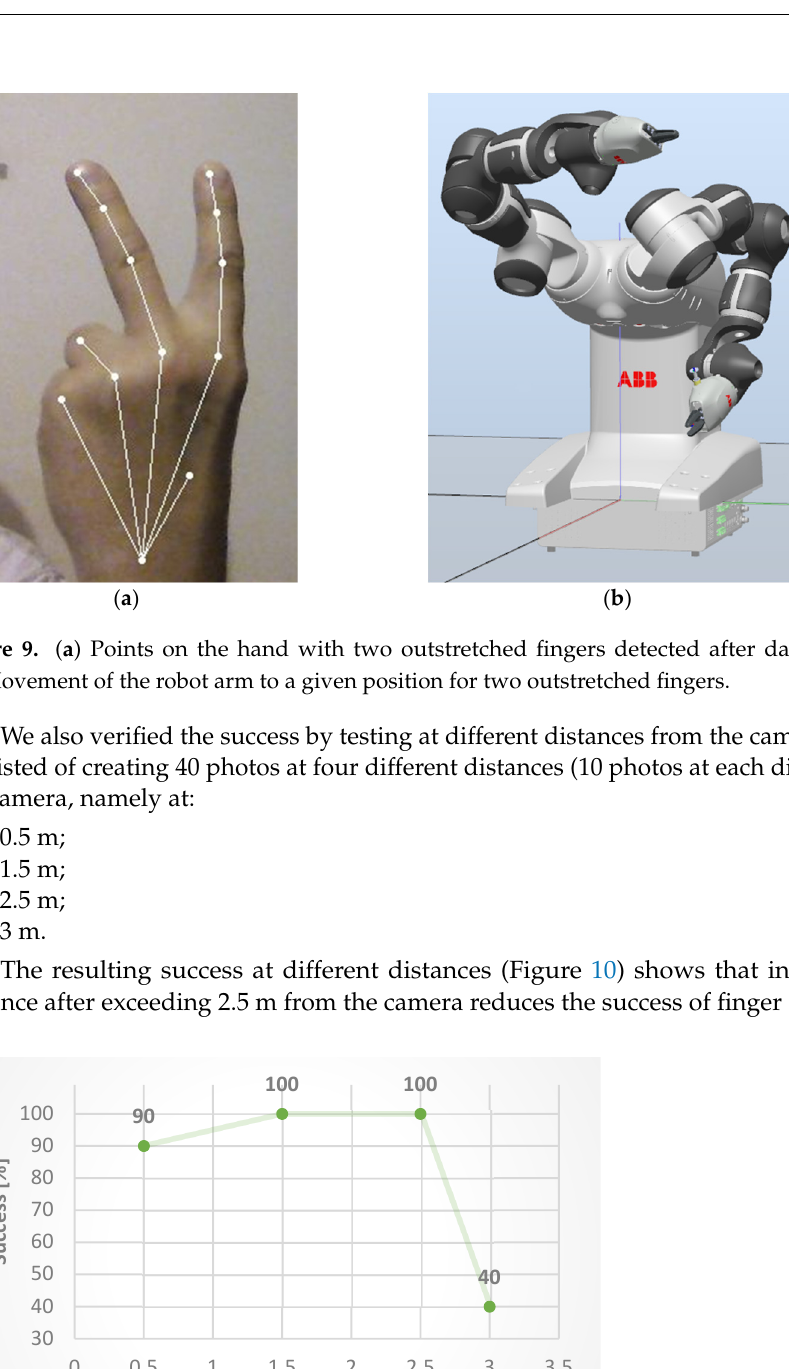
Figure 8. ( a ) Detected points on the hand with the result of 1 extended finger after data processing. ( b ) Movement of the robot arm to the appropriate position according to the number of outstretched fingers.